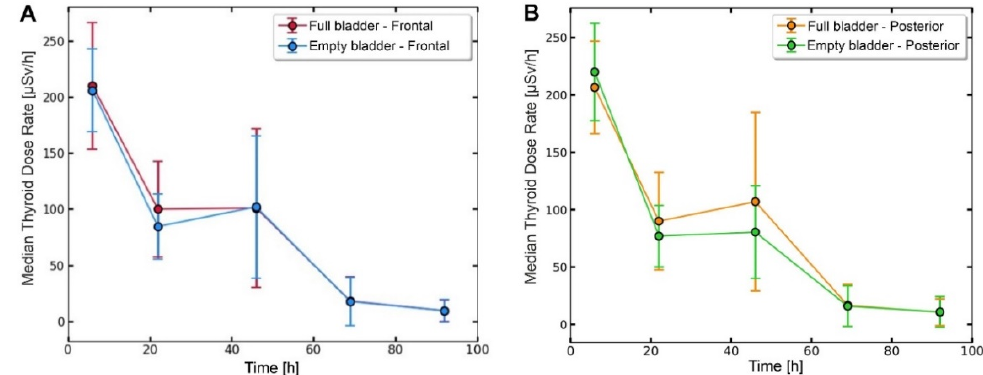
Figure 3. Variation over time of the dose rate measured at 1 m distance from the neck area ( A ) frontal position; ( B ) posterior position.